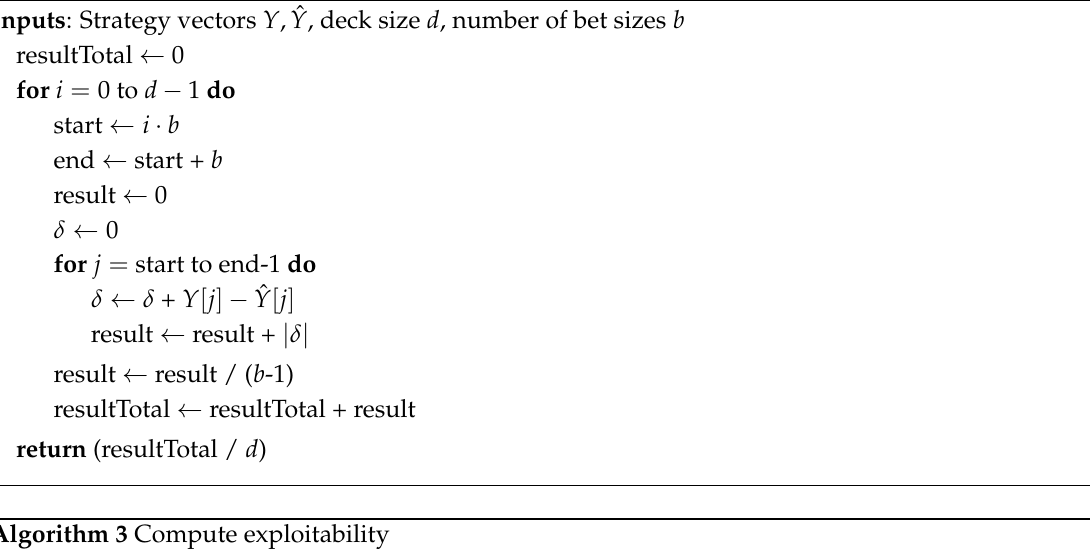
Algorithm 2 Distance between output vectors Y , ˆ Y